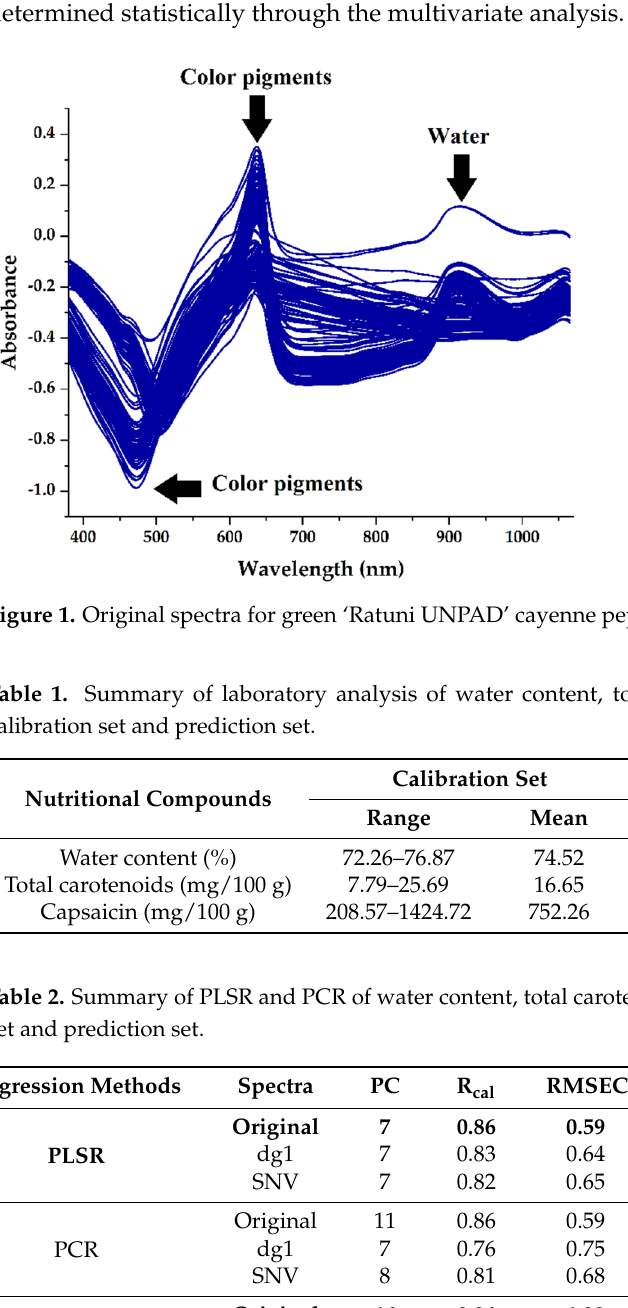
Table 1. Summary of laboratory analysis of water content, total carotenoids, and capsaicin in cali- bration set and prediction set.